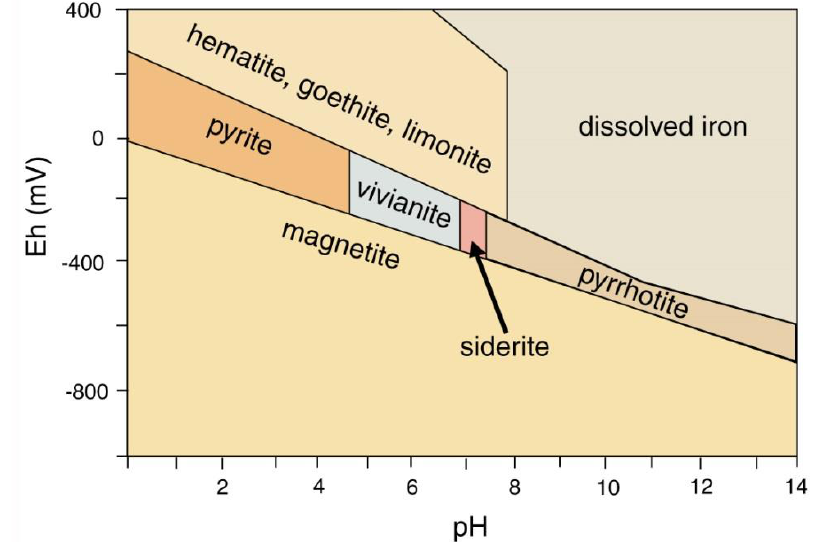
Figure 35. Phase relations for iron mineral in lacustrine environments. Plot based on data from [85,86]. Stability fields are affected by elemental availability, e.g., sulfides pyrite and pyrhottite precipitation requires sulfur, vivianite requires phosphorous.